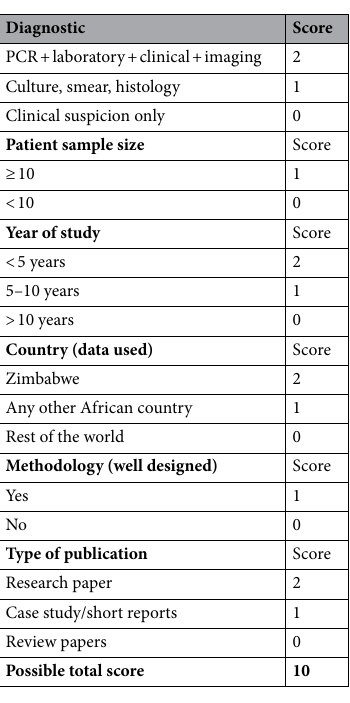
Table 2. Scoring system for modified GRADE